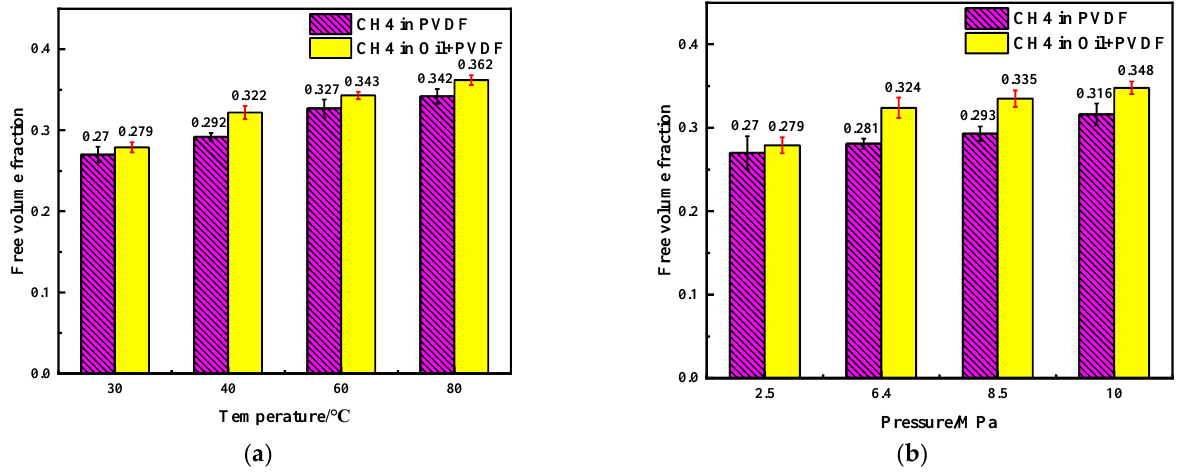
Figure 10. Free volume fraction of CH 4 in PVDF at different conditions: ( a ) 2.5 MPa, ( b ) 30 °C.